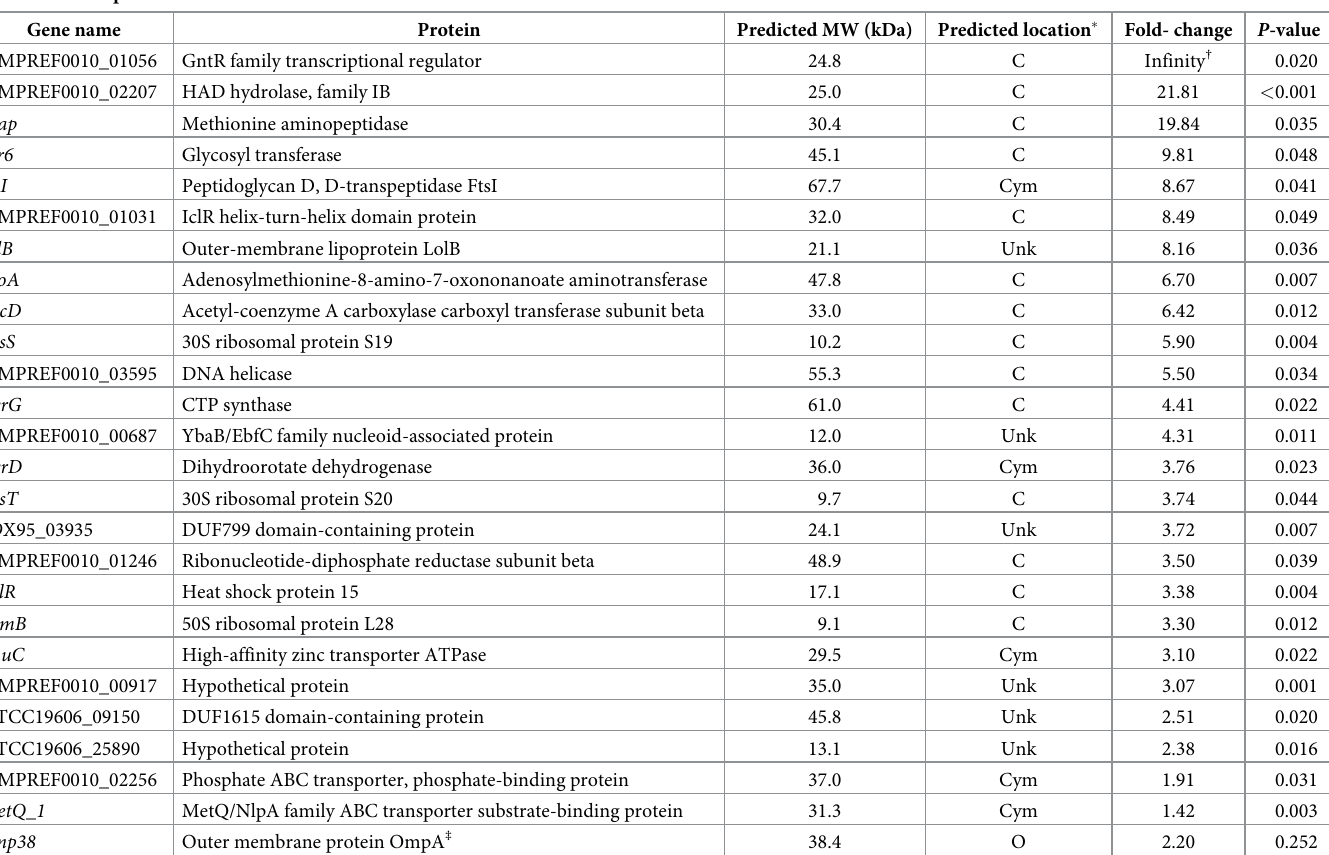
Table 3. List of proteins enriched in hAbOMVs with P value <